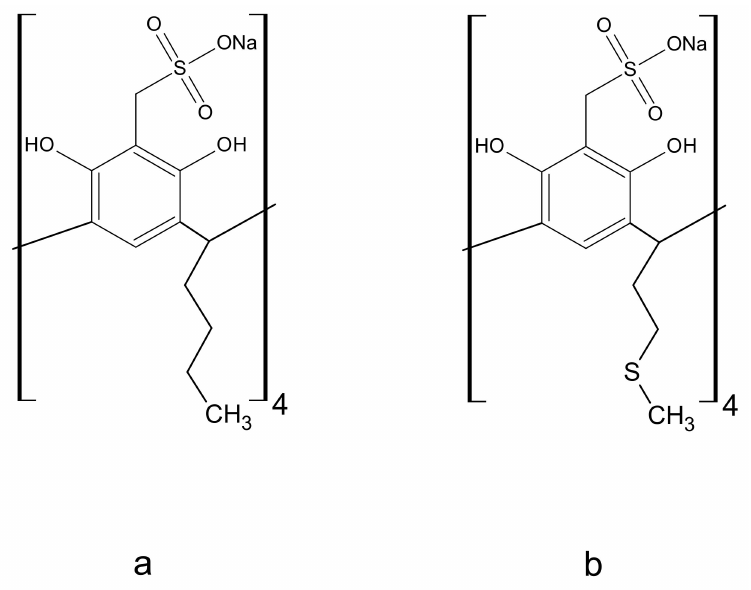
Figure 2. Resorcin[4]arenes sulfonated, whose complexing properties with Cu 2+ , Pb 2+ , Cd 2+ and Hg 2+ were evaluated. ( a ) Tetrasodium 5,11,17,23-tetrakissulfonate methylen-2,8,14,20- tetra(butyl)resorcin[4]arene (Na 4 BRA). ( b ) Tetrasodium 5,11,17,23-tetrakissulfonatemethylen- 2,8,14,20-tetra(2-(methylthio) ethyl)resorcin[4]arene (Na 4 SRA). Table 1. Techniques used to study the complexation of heavy metals with Na 4 BRA and Na 4 SRA. Host Cu